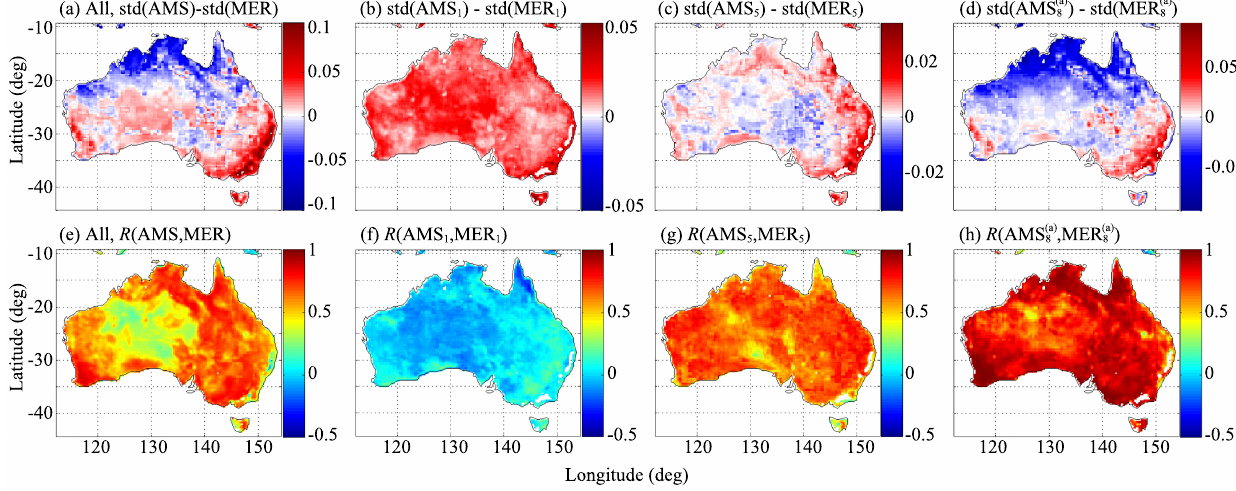
Figure 4. Difference in SD (in units of m 3 m − 3 ) and correlation R between AMS and MER for (a, e) all and (rest) on selected